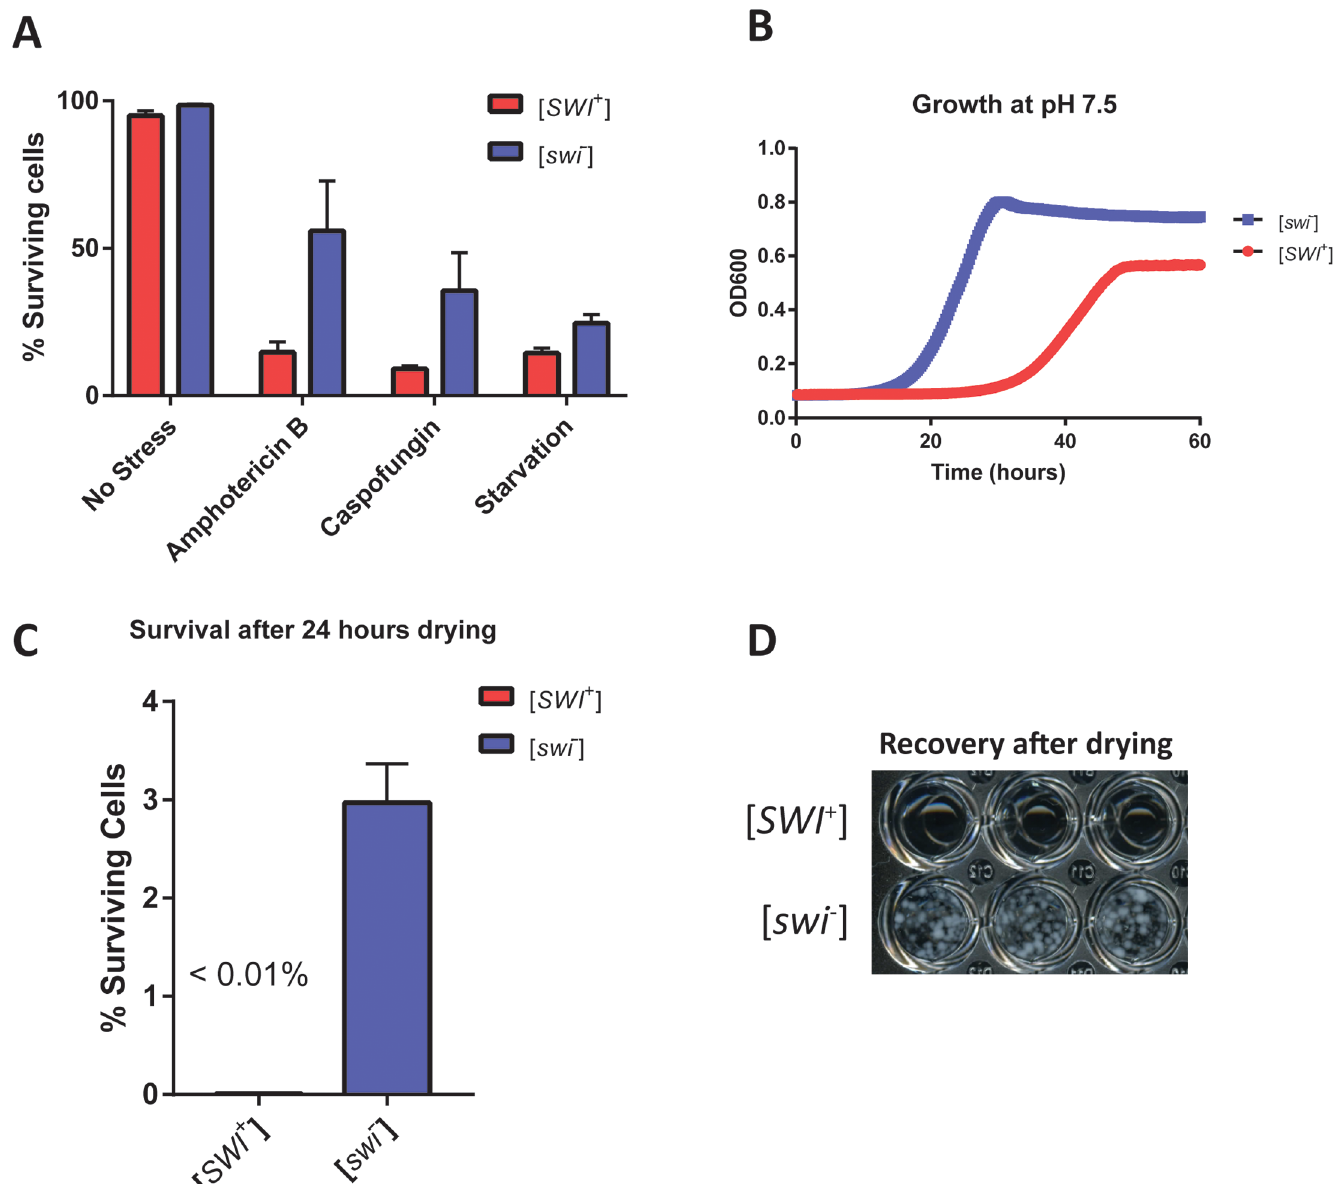
adhesion and thus